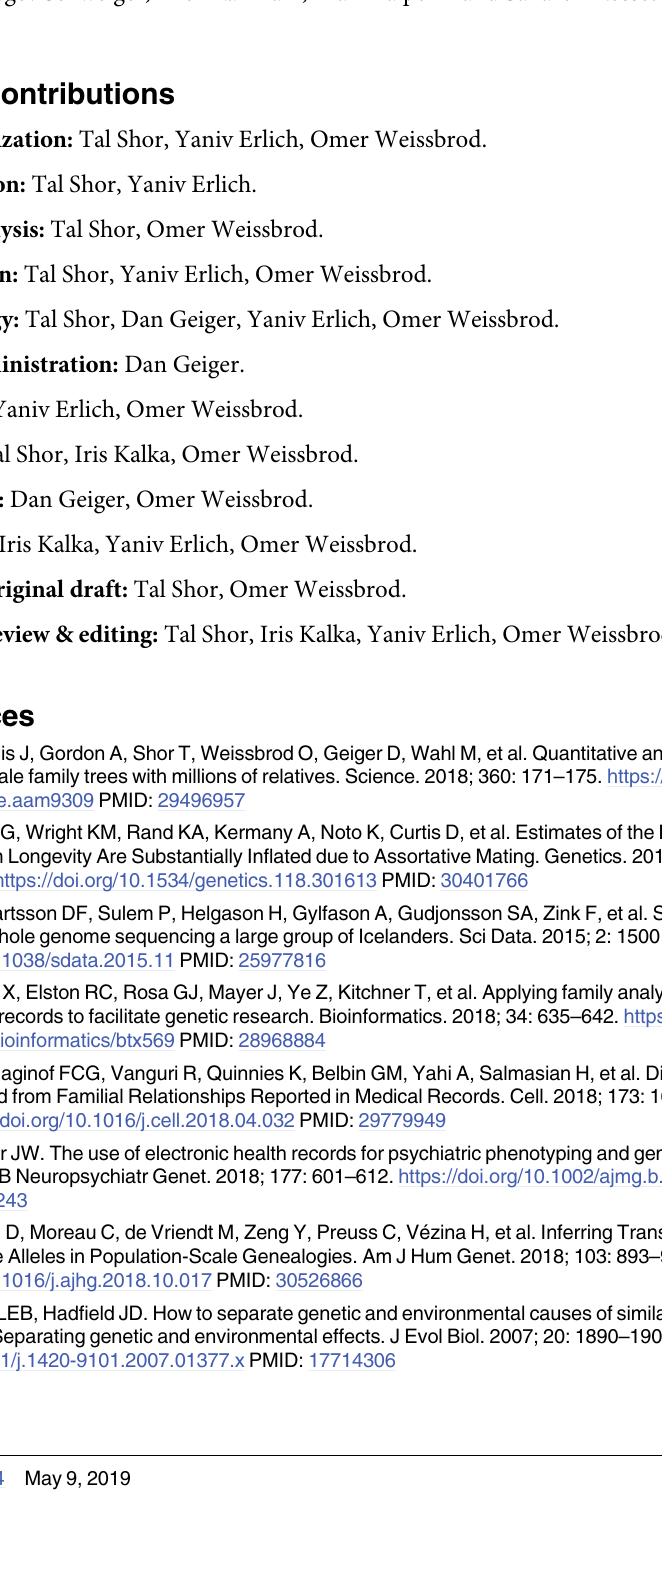
S2 Fig. The number of nonzero IBD and Dominance entries in the GENI dataset, as a func- tion of degree of relationship.